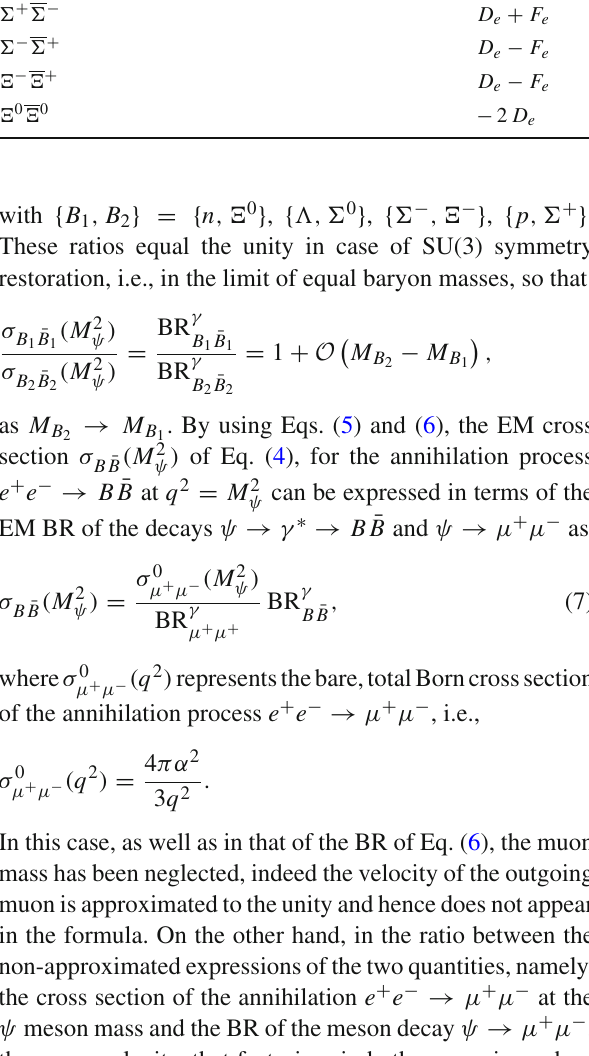
e and F e [3] γ ψ ( M 2 γ A ψ B ¯ B